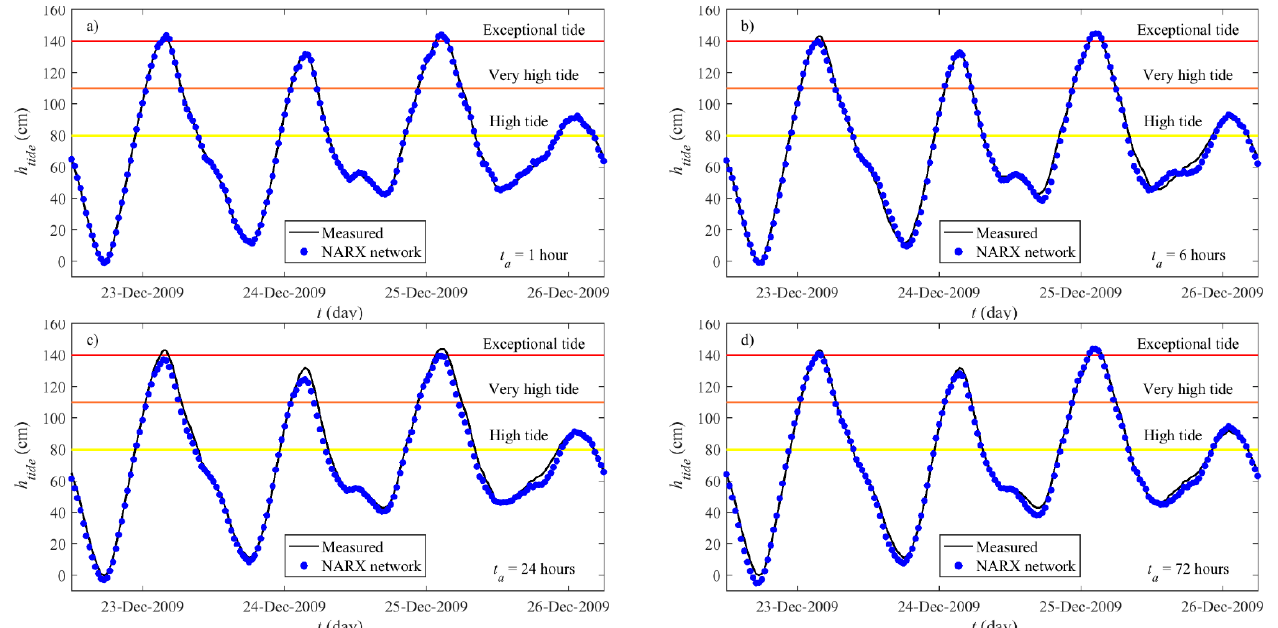
Figure 4. Tide prediction for Punta della Salute—Training and testing stage for Model I: t a = 1 h ( a ); t a = 6 h ( b ); t a = 24 h ( c ); t a = 72 h ( d ).